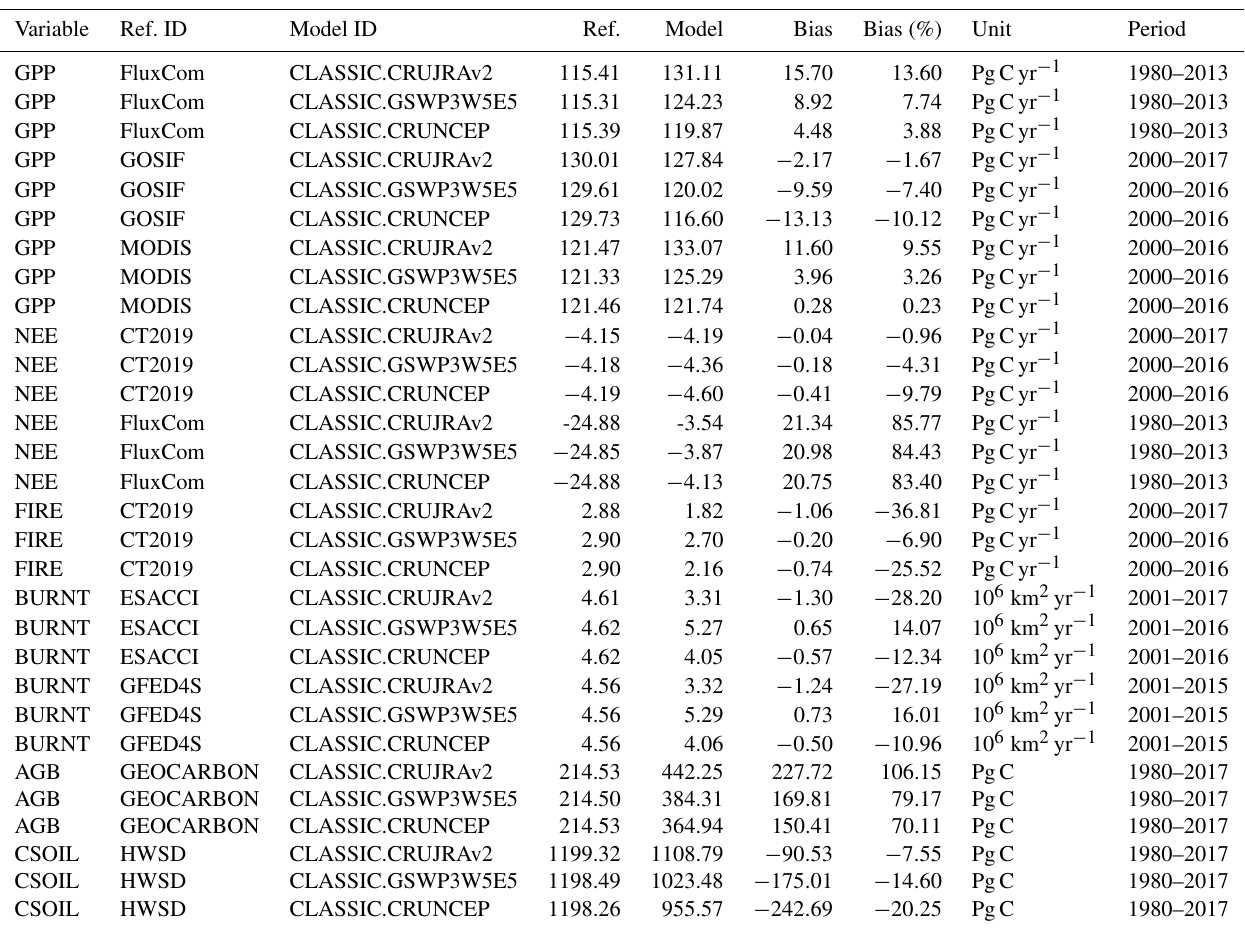
Table 3. Globally summed mean values and corresponding biases.